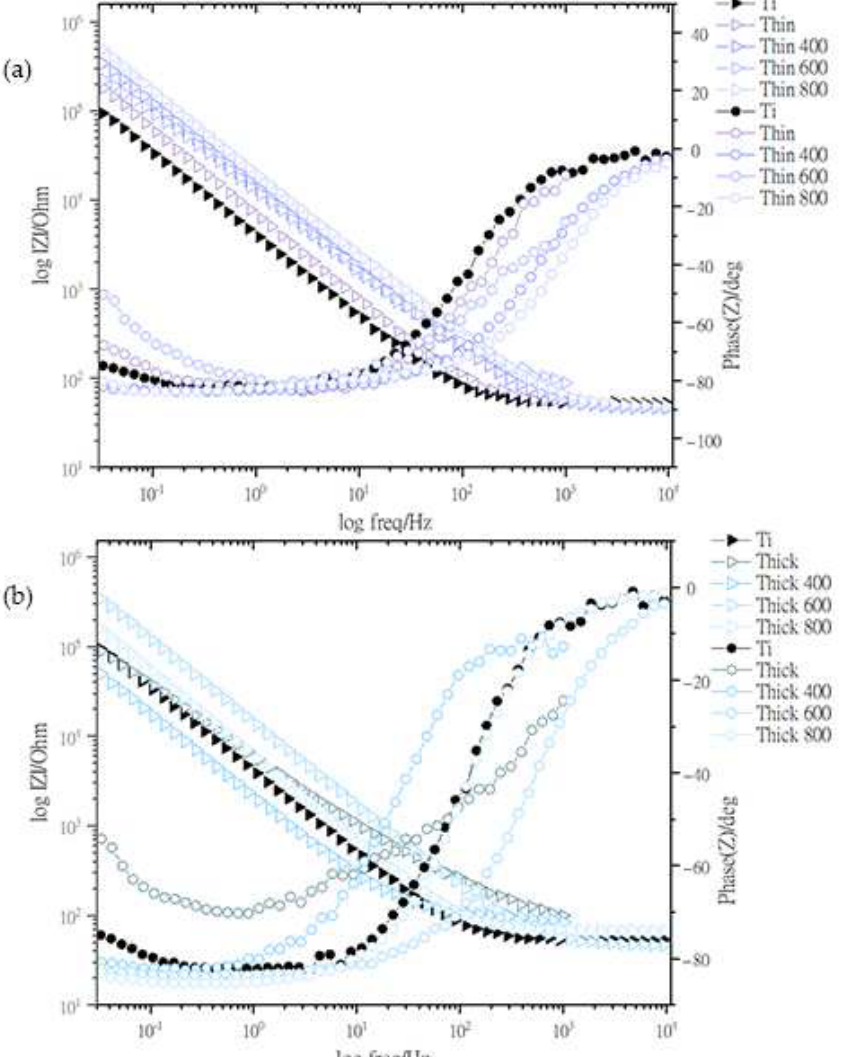
Figure 7. Impedance plots (Bode curve) of Co 30 Cr 20 Ni 20 Mo 20 Ti 10 alloy versus Ag/AgCl electrode in Hank’s solution. Working electrode was deposited at ( a ) 2 × 10 5 ion density (thin coat) without heat treatment and with heat treatment at 400 °C, 600 °C, and 800 °C ( b ); ( a ) 5 × 10 5 ion density (thin coat) without heat treatment and with heat treatment at 400 °C, 600 °C, and 800 °C.